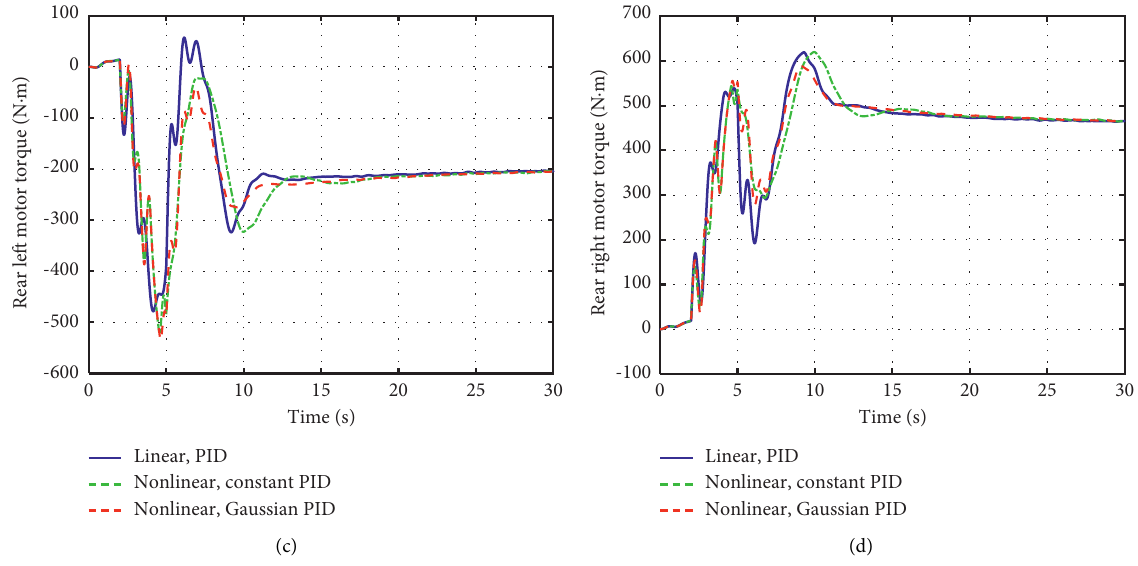
Figure 18: Comparison of motor output torque. (a) Front left tire. (b) Front right tire. (c) Rear left tire. (d) Rear right